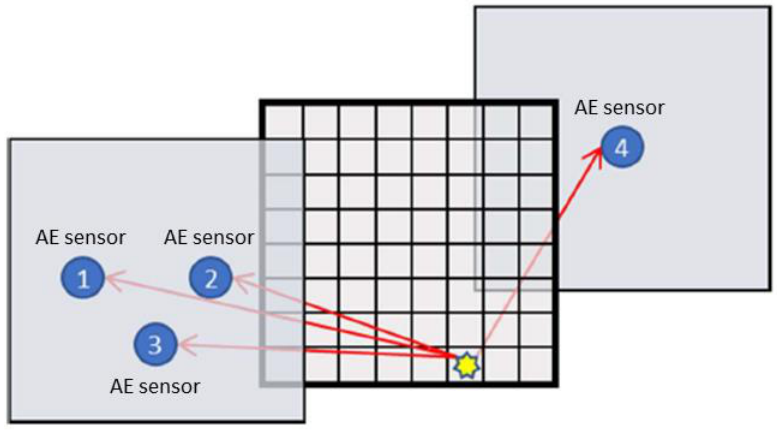
Figure 2. Schematic illustration of localisation approach.